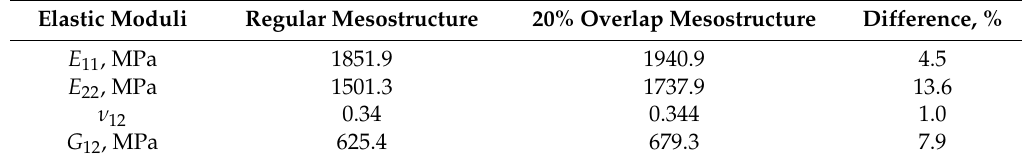
Table 5. Layer properties of the part processed by FDM for different air gap